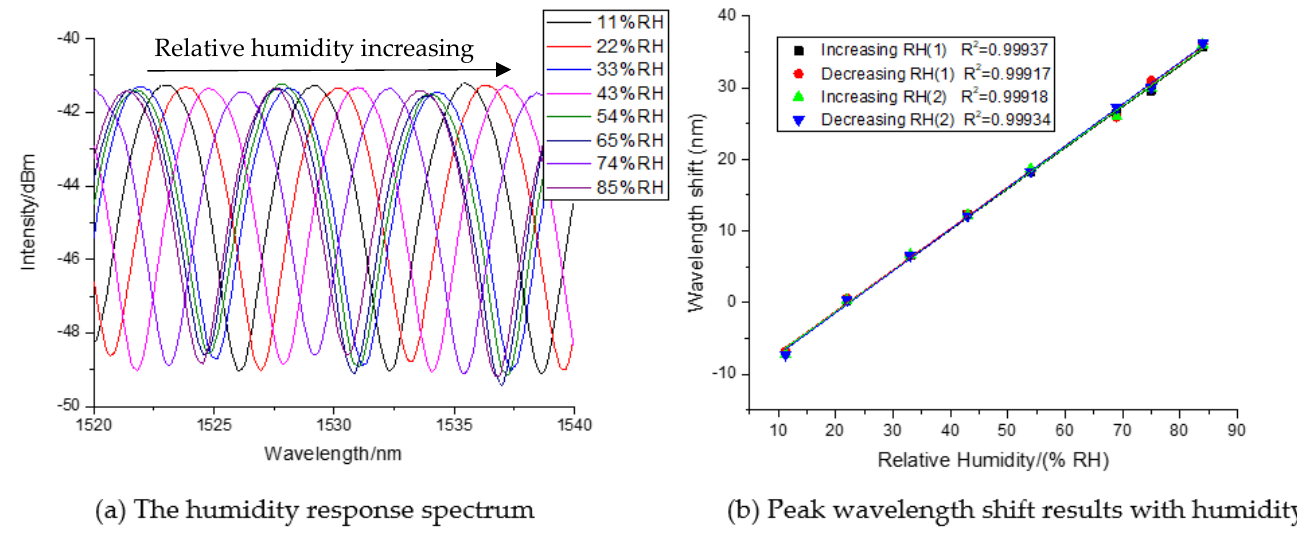
Figure 3. Humidity response results with a different humidity.